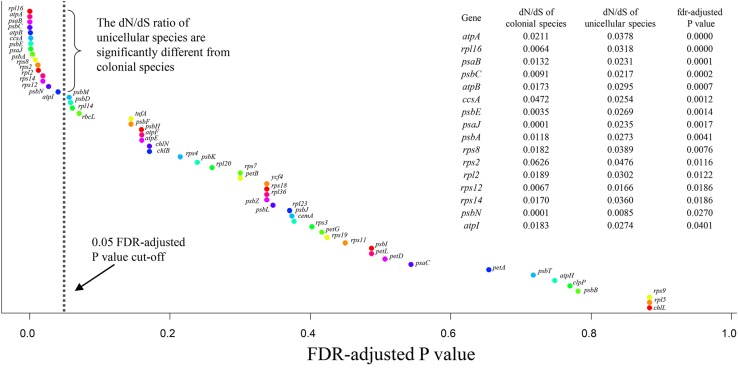
Plot showing ranked FDR-adjusted P values for 55 chloroplast protein-coding genes. P value were obtained from the branch model likelihood ratio tests, were applied by the false discovery rate method.